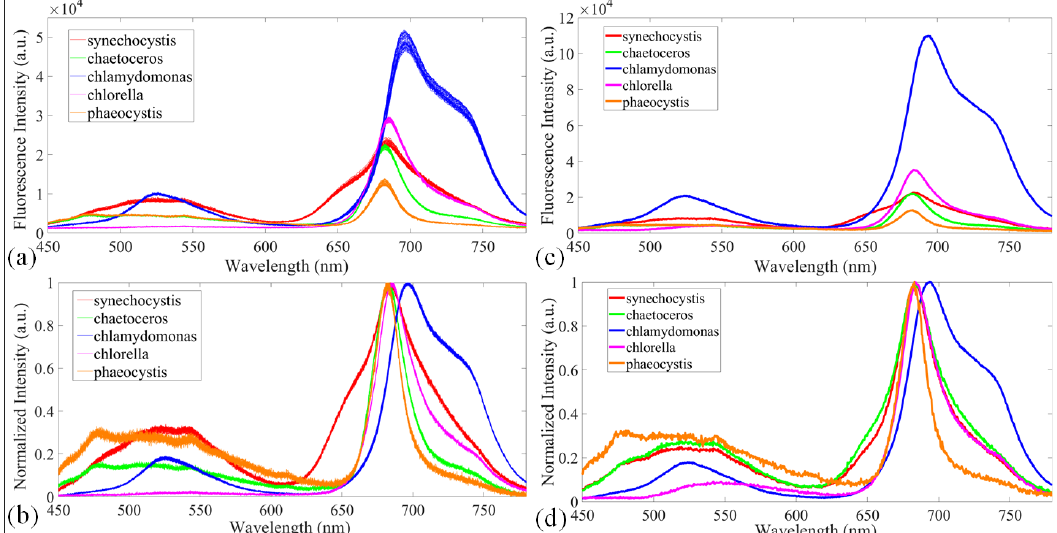
Figure 5. ( a ) Measured fluorescence spectra of five disaster-causing microalgae by the multi-mode microscopic hyperspectral imager (MMHI) system. ( b ) Normalized spectra of ( a ) through Equation (3). ( c ) Measured fluorescence spectra of five disaster-causing microalgae by a commercial spectrometer. ( d ) Normalized spectra of ( c ).